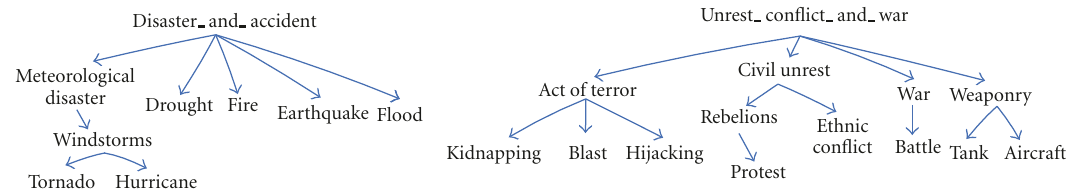
Figure 2: Subset of concepts and their hierarchy in the employed ontology for news. Two of the 17 top-level concepts (“Disaster and accident”, “Unrest, conflict, and war”) and a few of their subconcepts are depicted.